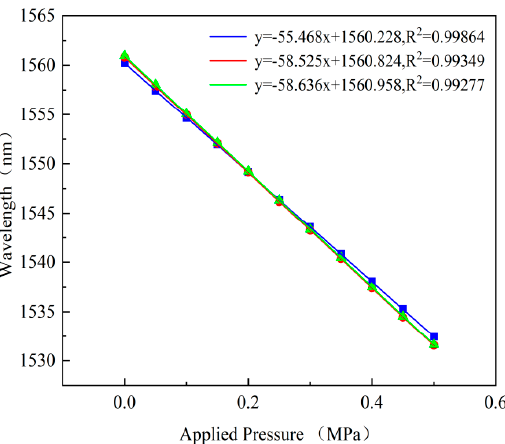
Figure 8. The repeatability of the sensor.